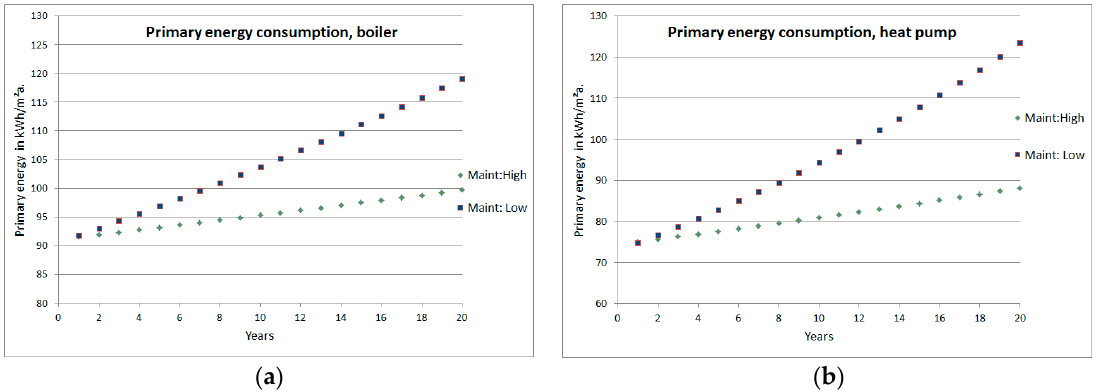
Figure 3. Impact of ( a ) boiler; ( b ) heat pump degradation on building primary energy consumption, two maintenance scenarios. Table 7. Cumulative results for single element degradation.